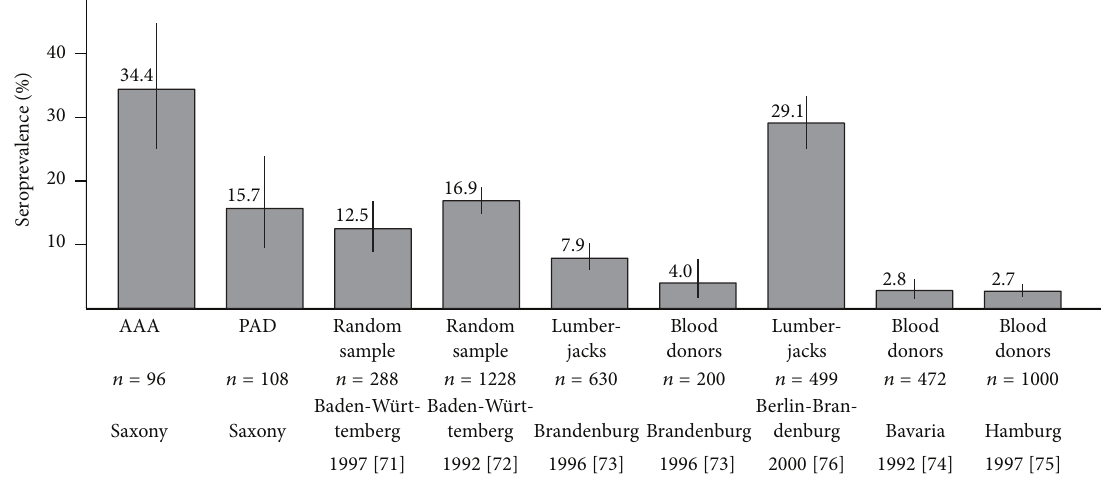
Figure 3: Seroprevalences for Borrelia burgdorferi sensu lato antibodies in different risk groups in Germany. Only studies with both ELISA and immunoblotting data were included. AAA, abdominal aortic aneurysm; PAD, peripheral artery disease. For details, see [70]. Reproduced with permission from